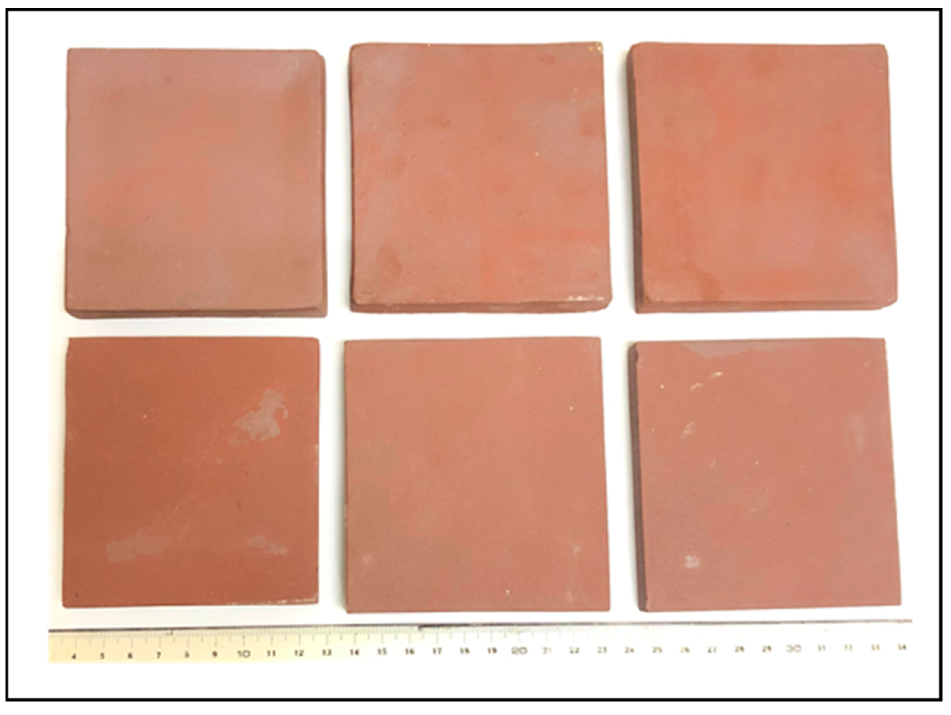
Figure 7. LB Tiles sintered at 1200 °C.